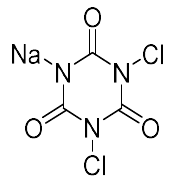
Figure 7. Structure of sodium dichloroisocyanurate (NaDCC).